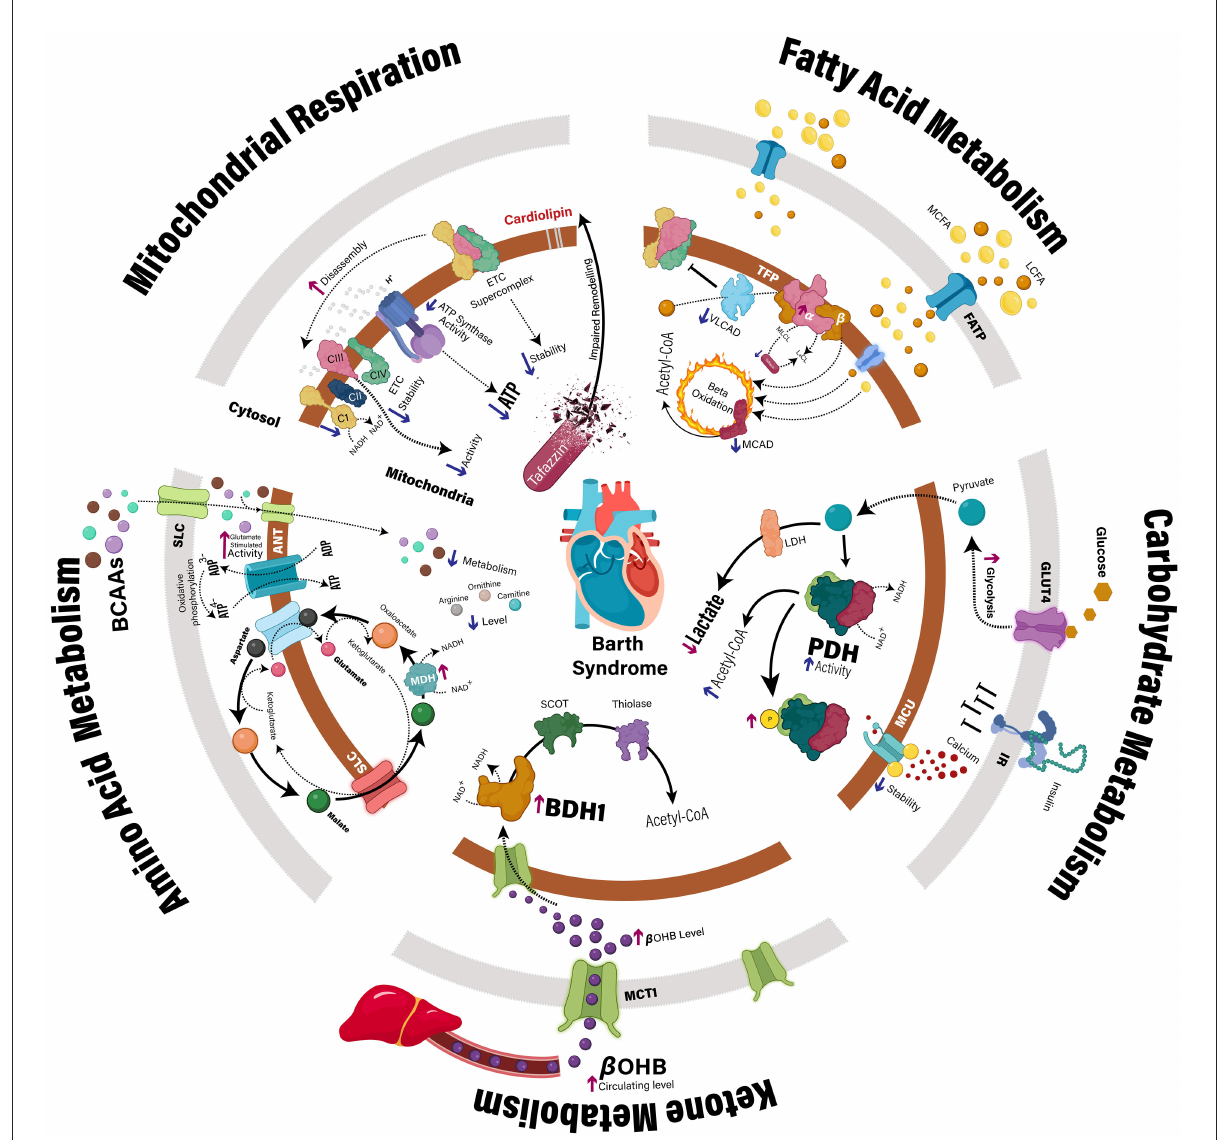
FIGURE1 Myocardial metabolic disturbances in Barth syndrome. Clinical and preclinical studies have identified multiple mechanisms that may contribute to impaired cardiac ATP production in the context of TAFAZZIN deficiency. In addition to direct impairment of the mitochondrial electron transport chain, specific defects have also been identified relating to the intermediary metabolism of fatty acids, carbohydrates, ketones, and amino acids. ANT, adenine nucleotide translocase; BCAA, branched-chain amino acid, BDH1, β -hydroxybutyrate dehydrogenase; β OHB, β -hydroxybutyrate; CI-IV, complex 1–4; GLUT4, glucose transporter type 4; IR, insulin receptor; LCFA, long-chain fatty acids; LDH, lactate dehydrogenase; MCAD, medium-chain acyl-CoA dehydrogenase; MCFA, medium-chain fatty acids; MCU, mitochondrial calcium uniporter; MDH, malate dehydrogenase; P, phosphate group; PDH, pyruvate dehydrogenase; SCOT, succinyl-CoA:3-ketoacid CoA transferase; SLC, solute carrier; TFP, mitochondrial trifunctional protein; VLCAD, very long-chain acyl-CoA dehydrogenase.